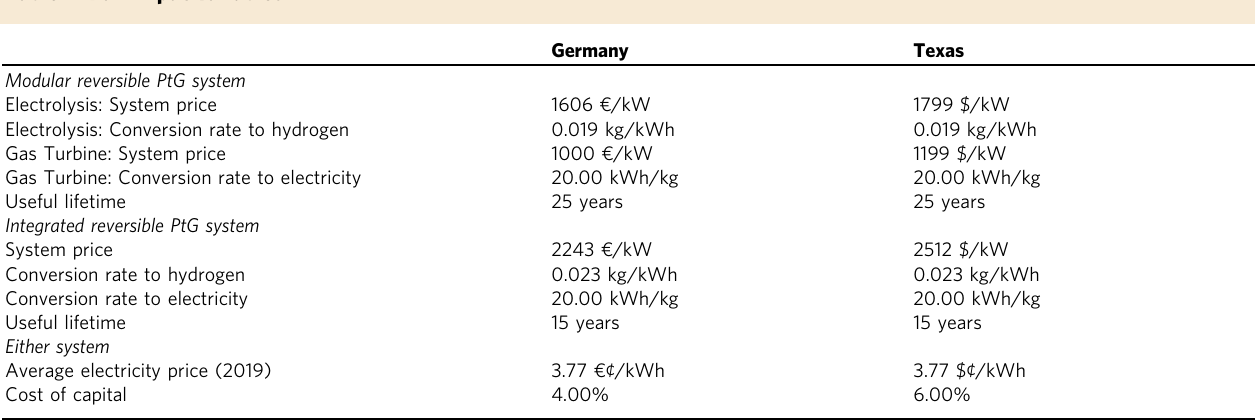
Table 1 Main input